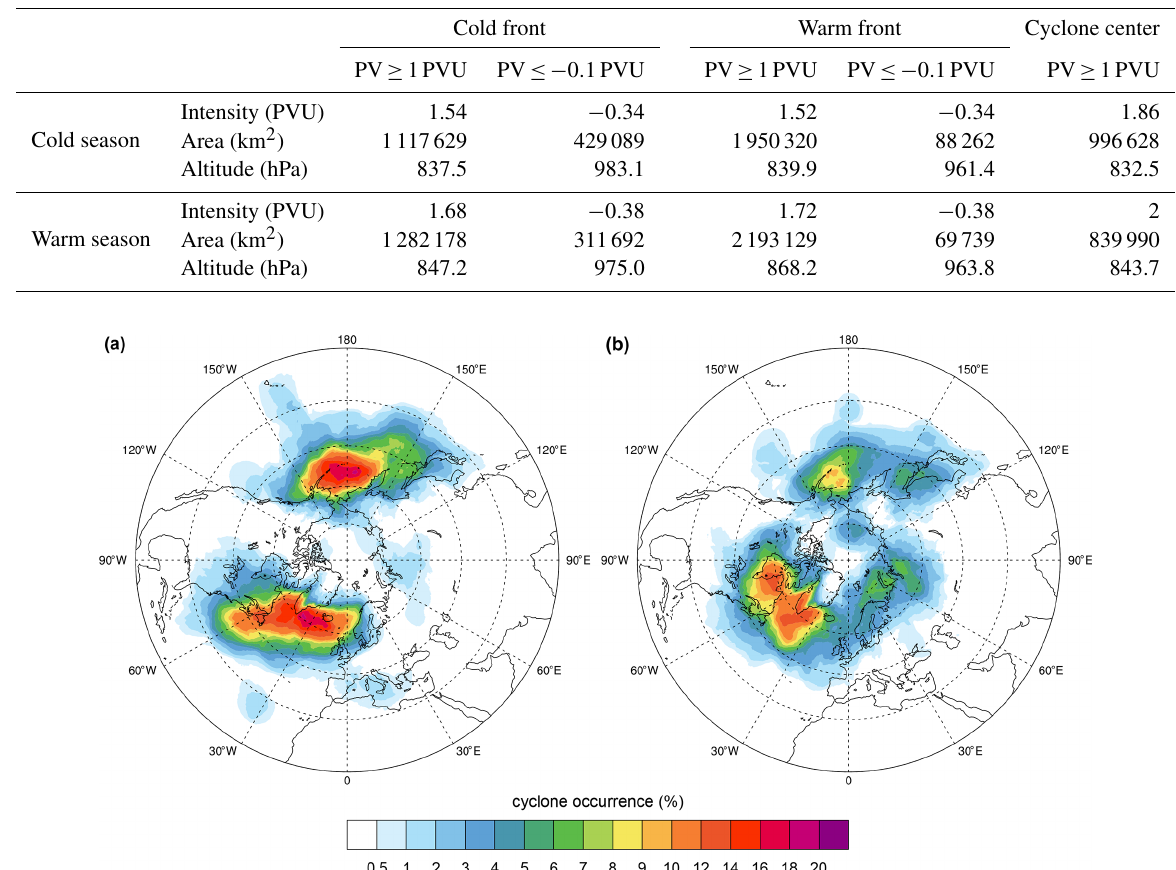
Table 4. Average intensity, area, and altitude of investigated PV anomalies.